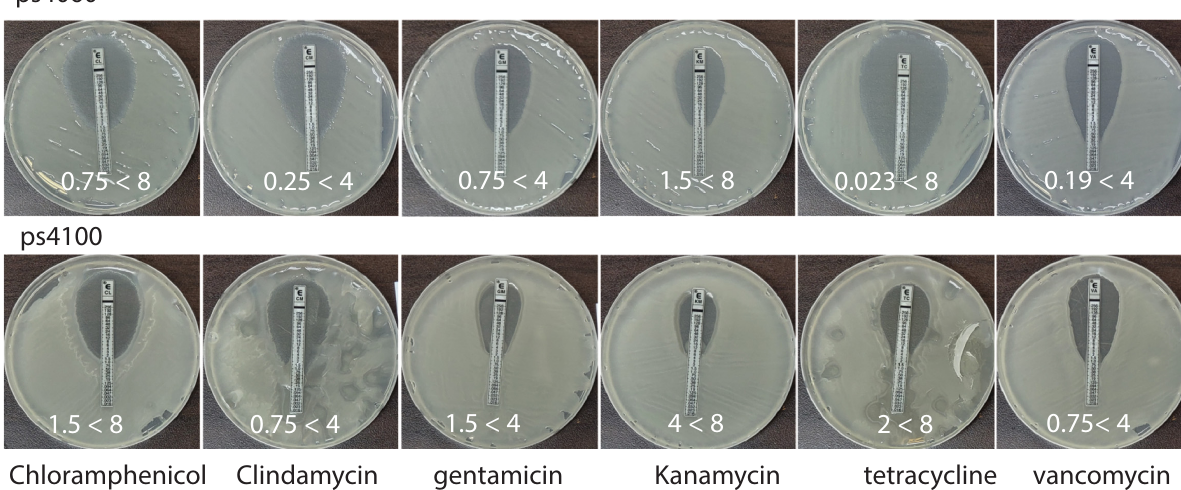
Fig 6. Susceptibility to six antibiotics. In each frame, the value on the left is the minimal inhibitory concentration (MIC) measured in this study; on the right is the acceptable MIC designated by the Korean Food and Drug Administration. The experiment was conducted using the Epsilometer test strip (E-test). Unit: μ